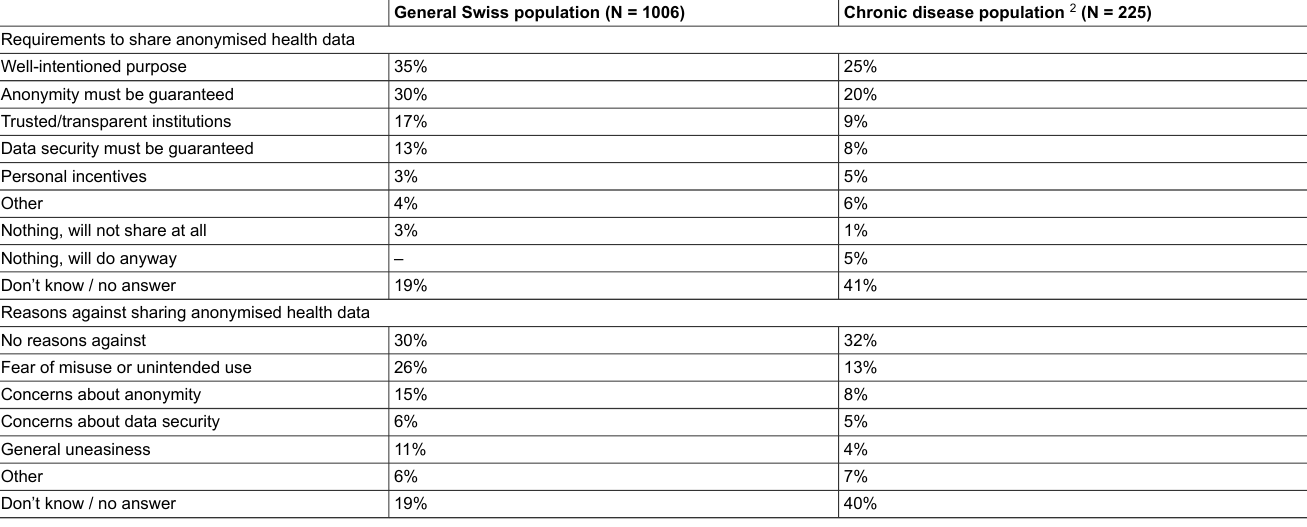
Table 2: Frequency of requirements mentioned (potential drivers or barriers) affecting the attitude to sharing anonymised data for medical research 1 . General Swiss population (N = 1006) Chronic disease population 2 (N = 225)